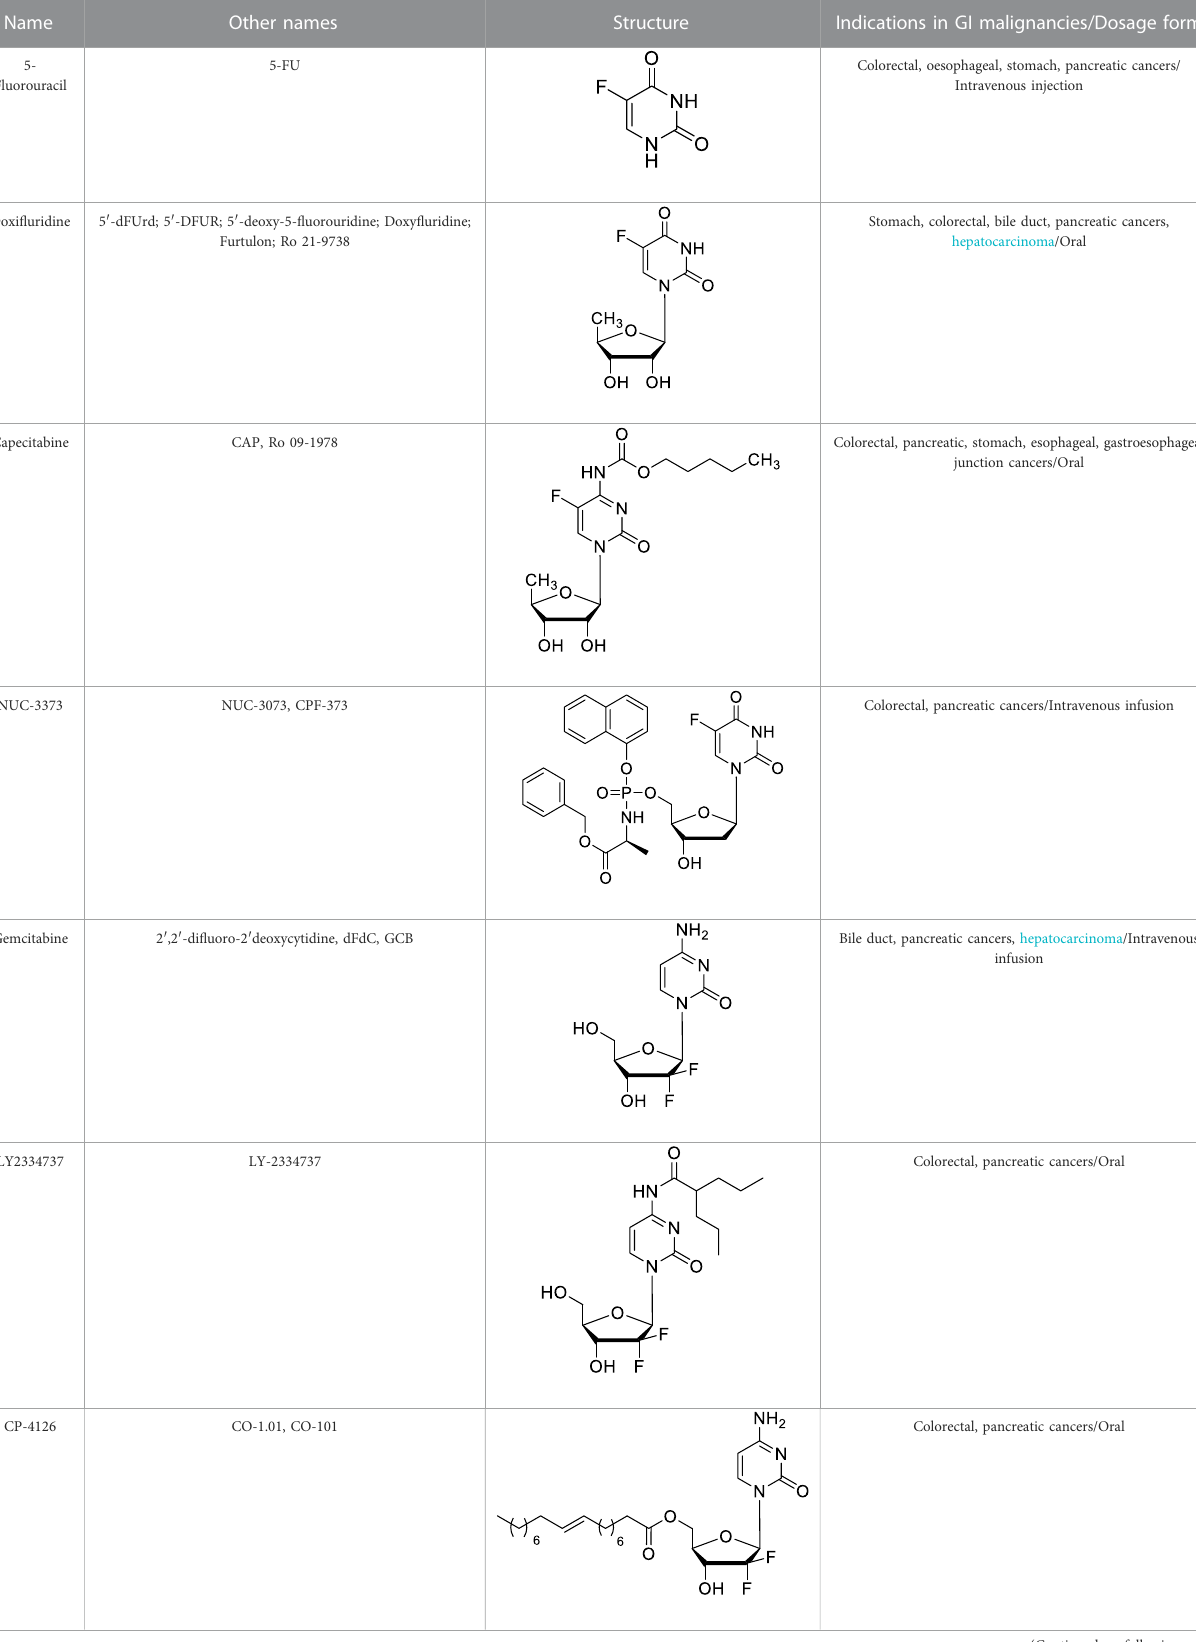
TABLE 1 The structures of NAs for the treatment of GI malignancies.